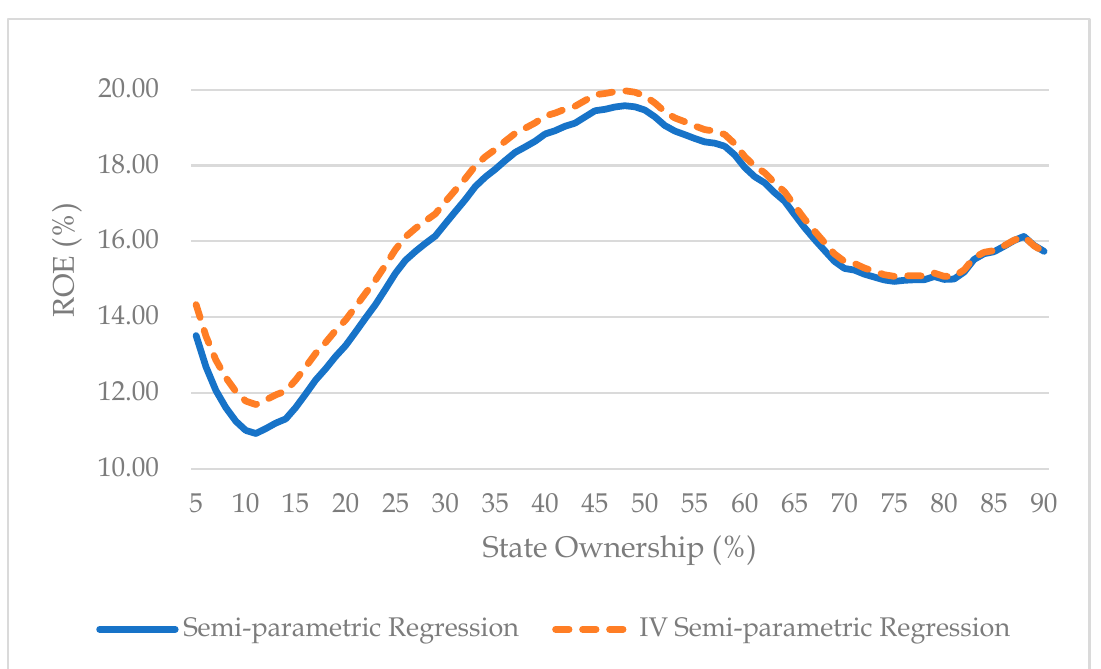
Figure A2. The marginal effect of state ownership (%) on partially privatized firm’s ROE (%) according to both semiparametric regression model and IV semiparametric regression model.